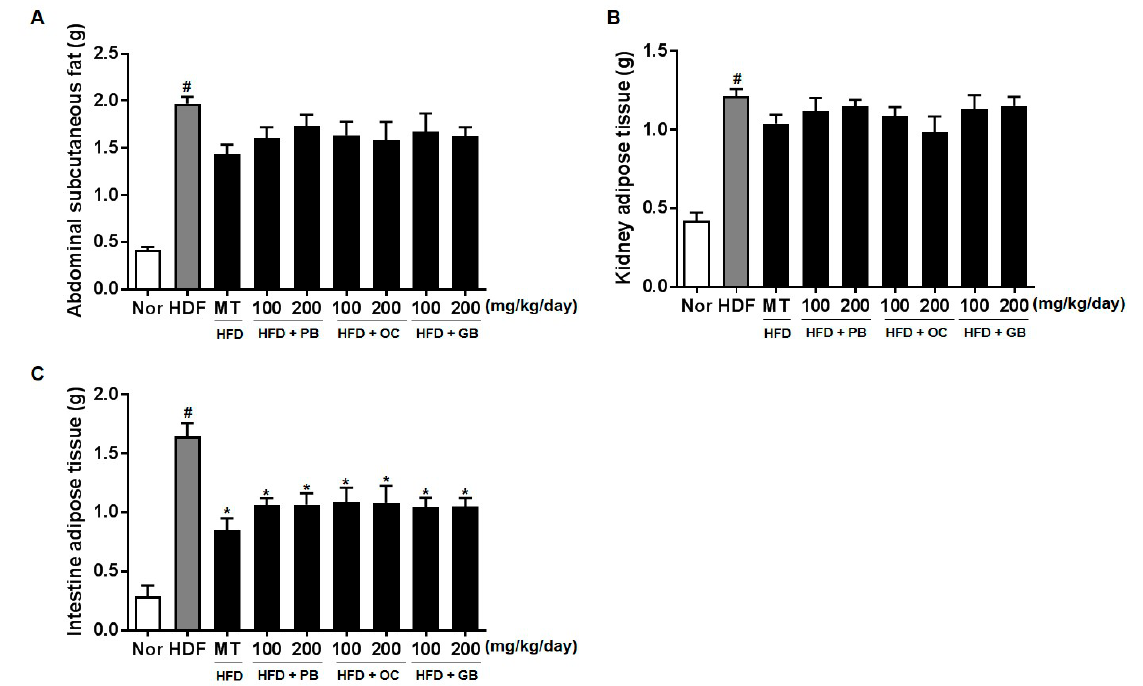
Figure 3. Effects of PB, OC, and GB extracts on body weight gain and body fat mass in HFD-fed mice: ( A ) abdominal subcutaneous fat, ( B ) kidney tissue, and ( C ) intestinal adipose tissue. The data are presented as the mean ± SEM ( n = 9); # p < 0.05 compared with the control group; * p < 0.05 compared with the HFD group.